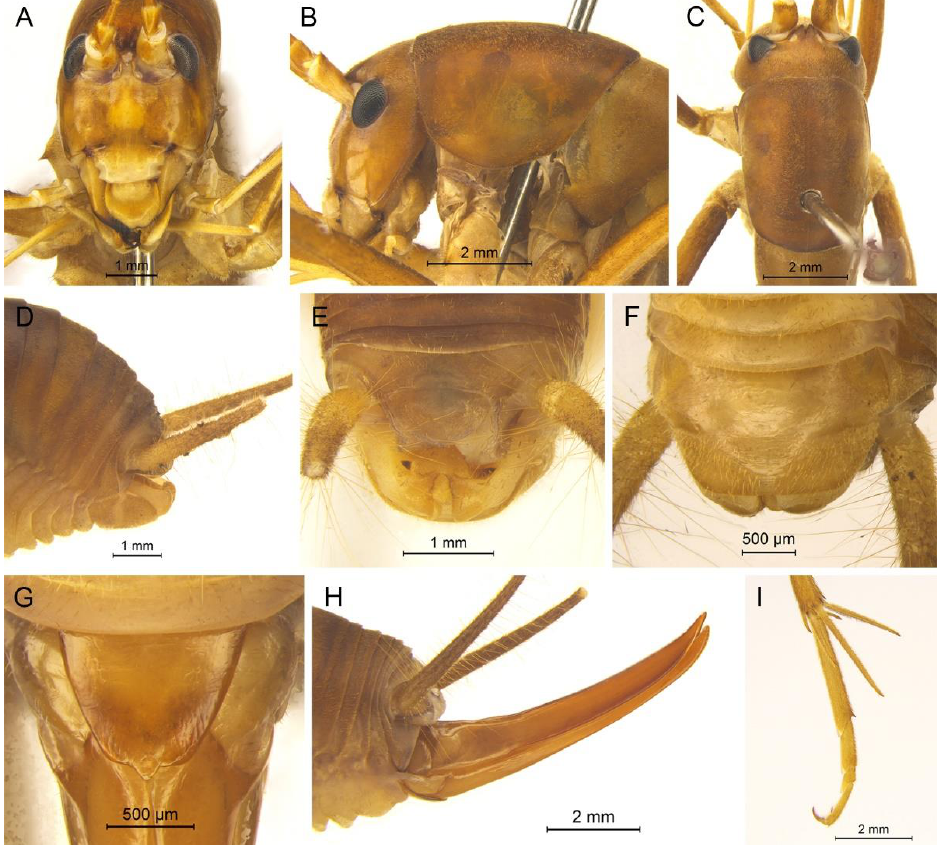
Figure 6. Gymnaetoides yangmingensis Zhu & Shi sp. nov., male: ( A – C ) head and pronotum: ( A ) frontal view, ( B ) lateral view, ( C ) dorsal view; ( D – F ) apex of abdomen: ( D ) lateral view, ( E ) dorsal view, ( F ) ventral view; ( I ) hind tarsus in lateral view; female: ( G ) subgenital plate in ventral view; ( H ) ovipositor in lateral view. All abdominal tergites without process. Epiproct ligulate, paraproct triangular in lat- eral view. Cercus slender, conical, apex acute. Dorsal sclerite of genitalia quadrangular, basal area wide, with concavity; basal area of dorsal median lobe with paired lateral scle- rites, semicircular, apical area divided into two lobes; dorsal lateral lobes broad, nearly equal in length to dorsal median lobe, apical area spinous; ventral lateral lobes much shorter than dorsal lateral lobes; ventral median lobe short. Subgenital plate transverse and wide, posterior margin straight. Female: Appearance is similar to male. Ovipositor longer than half the length of hind femur, slightly curved upward, dorsal margin smooth, apical area of ventral margin den- ticulate. Subgenital plate trapezoidal, posterior margin slightly protruding. Coloration. Body light brown, uniform.